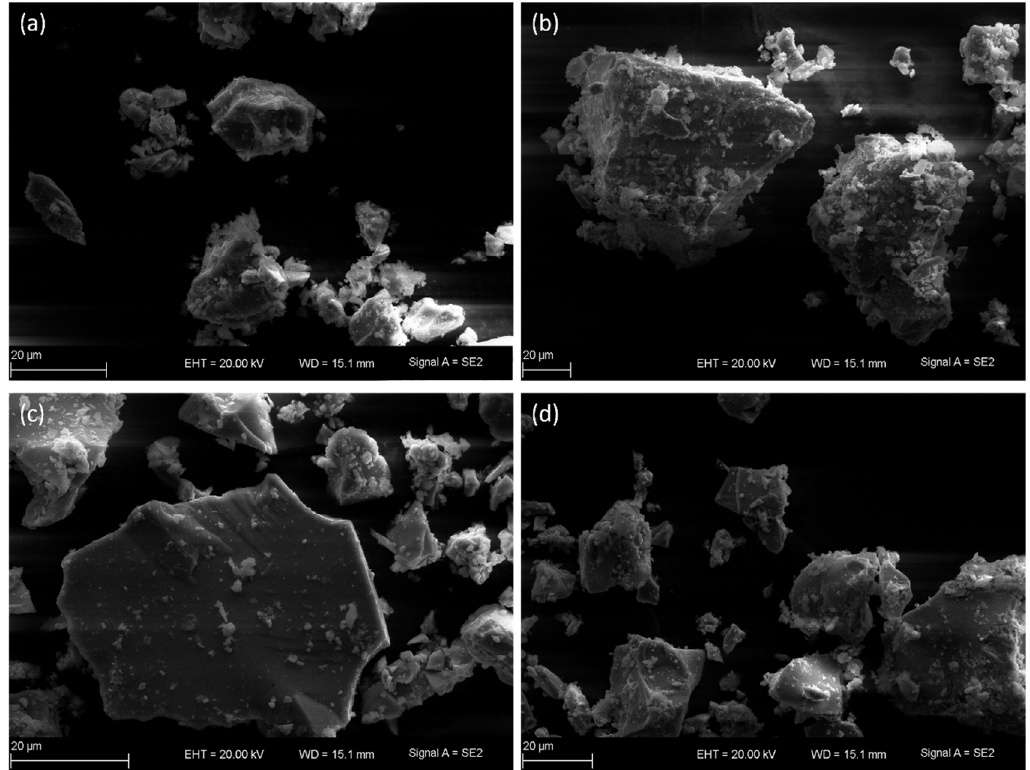
Figure 7. SEM micrograph of ( a ) MgNi 2 , ( b ) Ca x Mg 1 − x Ni 2 ( x = 0.33), ( c ) CaNi 2 , ( d ) Ca x Mg 1 − x Ni 2 ( x = 0.5).